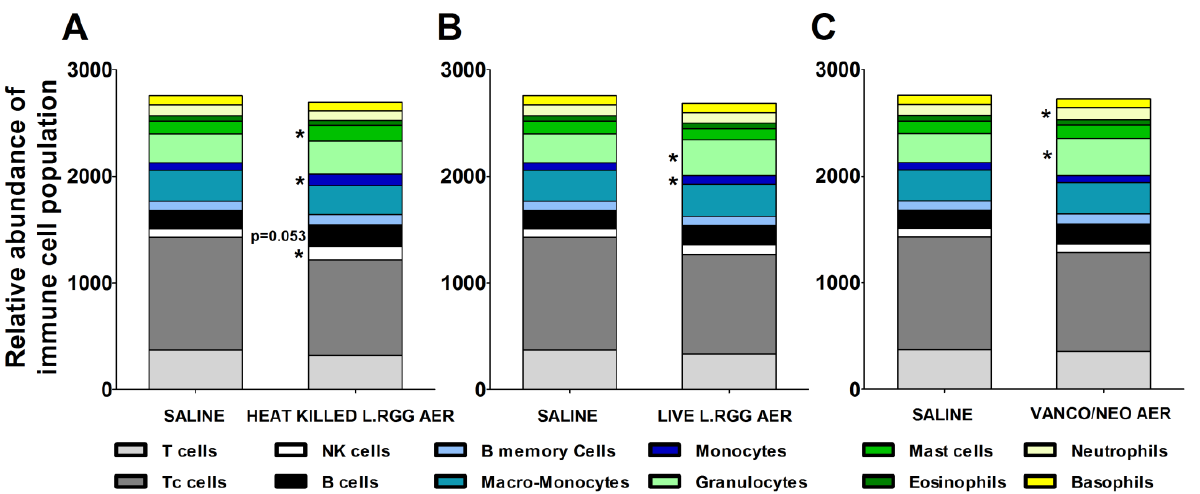
Figure 5. Immunological effects of vanco/neo and dead or live probiotic aerosolization on the lung microenvironment. Relative abundance of different immune cell populations in ( A ) heat killed L.RGG -, ( B ) live L.RGG - or ( C ) antibiotic-treated lungs obtained after TIMER 2.0 analysis of data from gene expression profile (9 samples/group) (mean ± SEM). * p ≤ 0.05 by unpaired Student t -test.